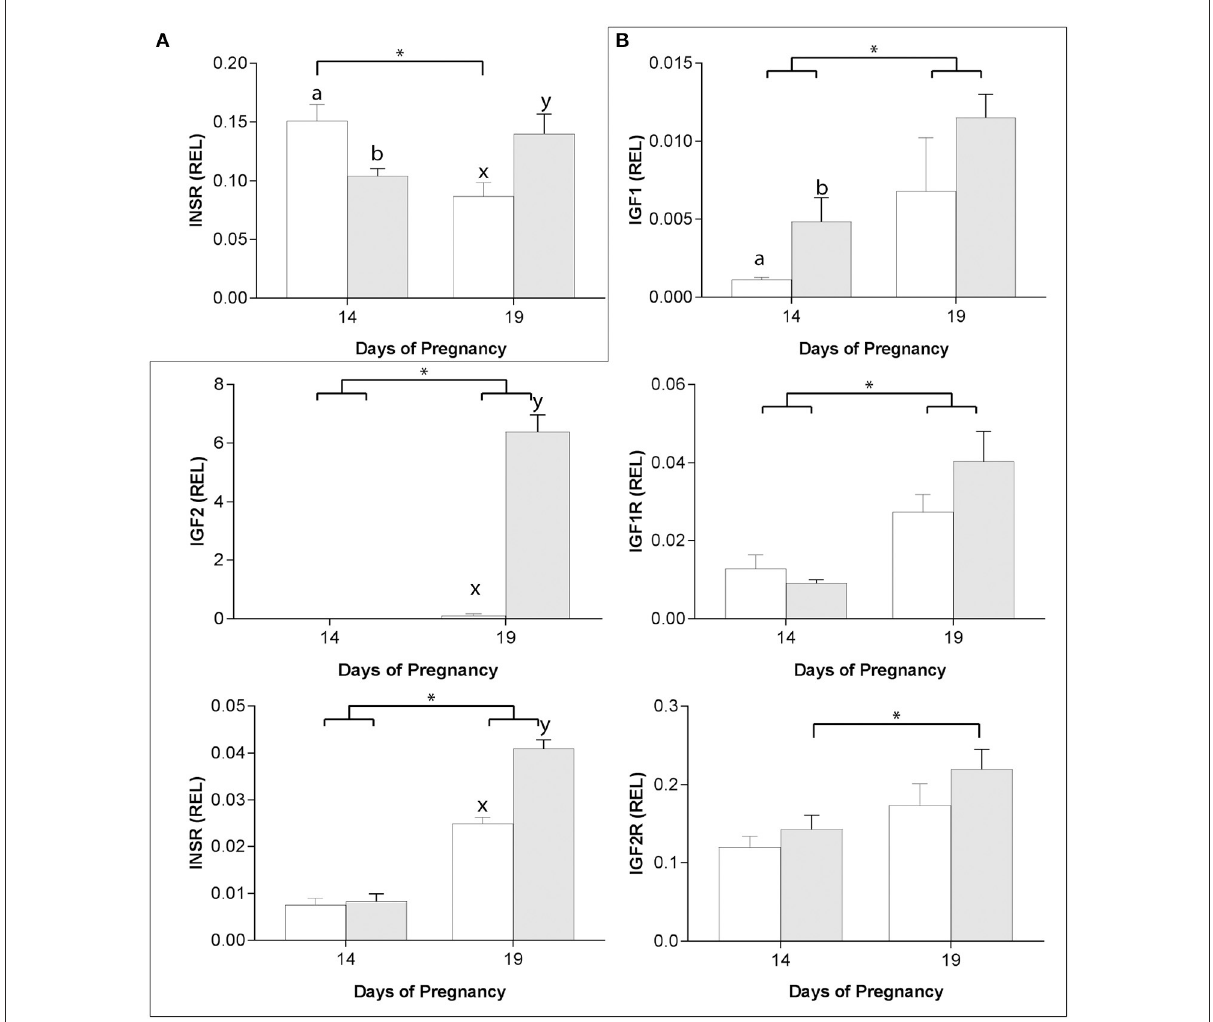
FIGURE5 Relative gene expression (mean ± s.e.m) on days 14 and 19 of pregnancy after transfer of day 8 horse embryos to asynchronous (day 3: white bars) or synchronous (day 8: gray bars) recipient mares, for INSR in the endometrium (A) and for IGF1 , IGF2 , IGF1R , INSR , and IGF2R in the conceptus membranes (B) . Values are calculated as the ratio of the target gene mean value to the geometric mean for the reference genes ( GAPDH , PGK1 and SRP14 for the conceptus, and GAPDH , HPRT1 , PGK1 and SRP14 for the endometrium). Significant differences ( P < 0.05) between group (asynchronous vs. synchronous) within the same day are depicted by different superscripts (day 14: a, b; day 19: x, y) while pregnancy stage differences within a group are indicated by an asterisk